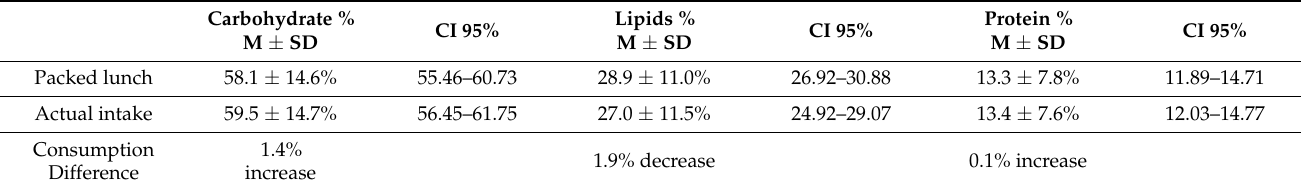
Table 2. Packed lunch macronutrient content vs. actual consumption ( n =